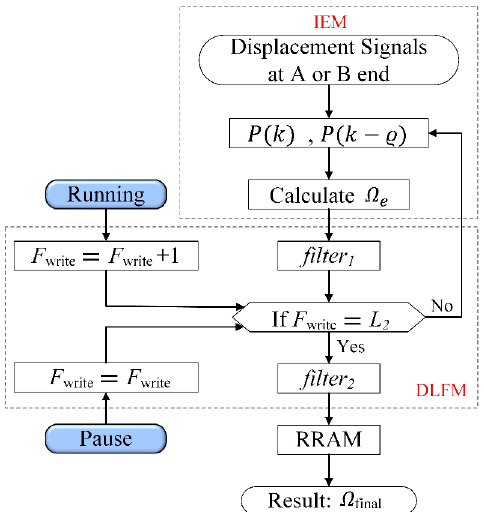
Figure 5. Flow chart of the frequency estimator.